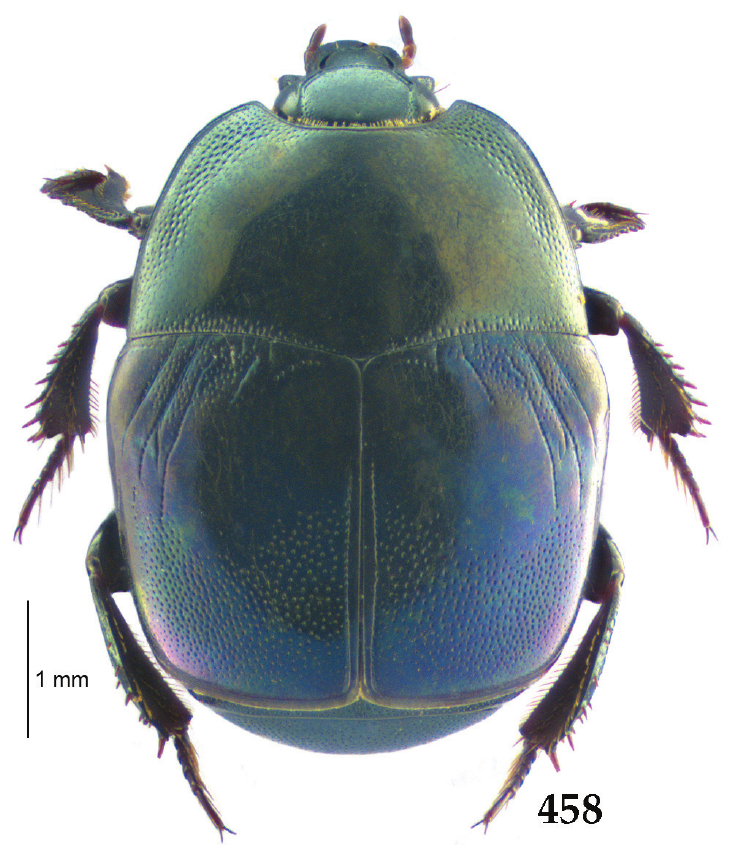
Figure 458. Saprinus ( Saprinus ) laetus Erichson, 1834 habitus, dorsal view. tarsus missing, with following labels: “New Zealand” (round label, written); followed by: “Type” (round, red-margined printed label); followed by: “Saprinus pseudocyaneus / White Zool. Erebus & Terror” (written); followed by: “Sapr. cyaneus / G Dahlgren det.” (printed-written); followed by: “Saprinus pseudocyaneus / White, 1846 / LEC- TOTYPE / Des. T. Lackner & R. Leschen 2014” (red label, written) (BMNH). This specimen is clearly the type of S. pseudocyaneus , and may be errorneously described from New Zealand, where it normally does not occur; though there are four specimens among S. pseudocyaneus material collected from New Zealand in 1930 (see below). For the taxonomic history of this species see Kuschel (1987). This species was described from unknown number of specimens and the lectotype designation fixes the identity of the species. Saprinus gayndahensis MacLeay, 1871: Lectotype, sex unidentified, present desig- nation, with the following labels: “Gayndah, / Queensland / Masters” (printed); fol- lowed by: “Co-type” (printed); followed by: “13739 / Saprinus / gayndahensis / Mast. / Queensland / Cotype” (written); followed by: “SAMA Database / No.